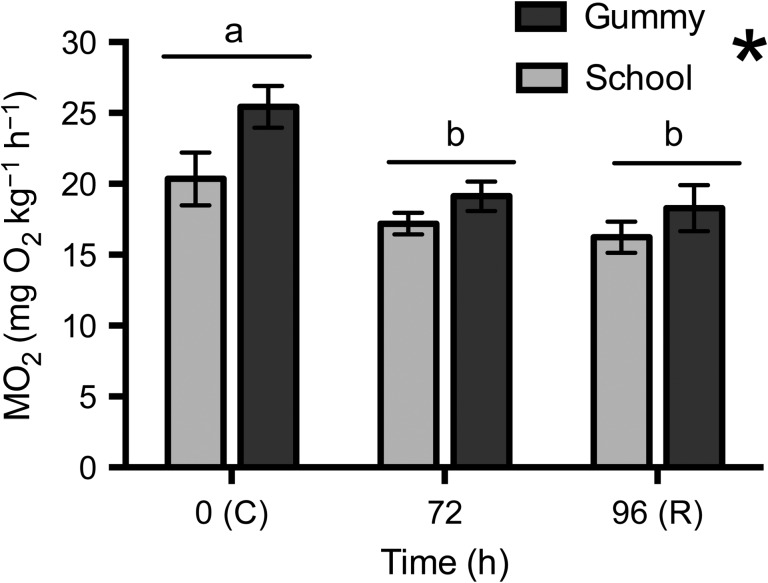
Routine oxygen consumption (MO2; in milligrams of O2
per kilogram per hour; mean values ± SEM) in school
sharks (G. galeus) and gummy sharks (M.
antarcticus) following exposure to 75% seawater.
Different letters indicate statistically significant differences over time.
Asterisk indicates significant effect of species
(P < 0.05; school sharks,
n = 6; gummy sharks,
n = 5).